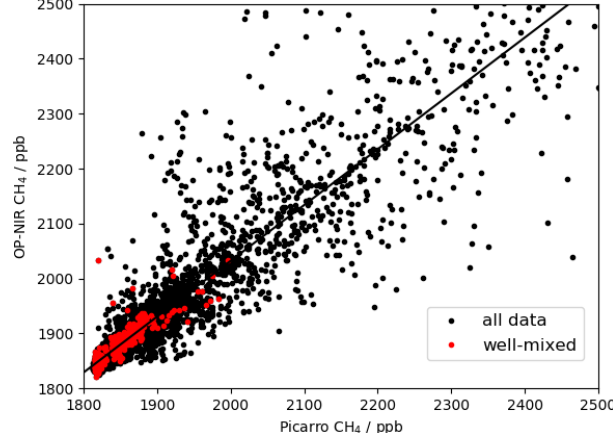
Figure 9. Comparison of path-averaged CH 4 measured by the open- path NIR and in situ CH 4 measured by the CRDS. All data points are shown in black, with those from well-mixed conditions (wind speeds greater than 2ms − 1 and from the westerly sector) in red. The best-fit line of OP-NIR = 1.0161 ± 0.0004 × Picarro for the fit